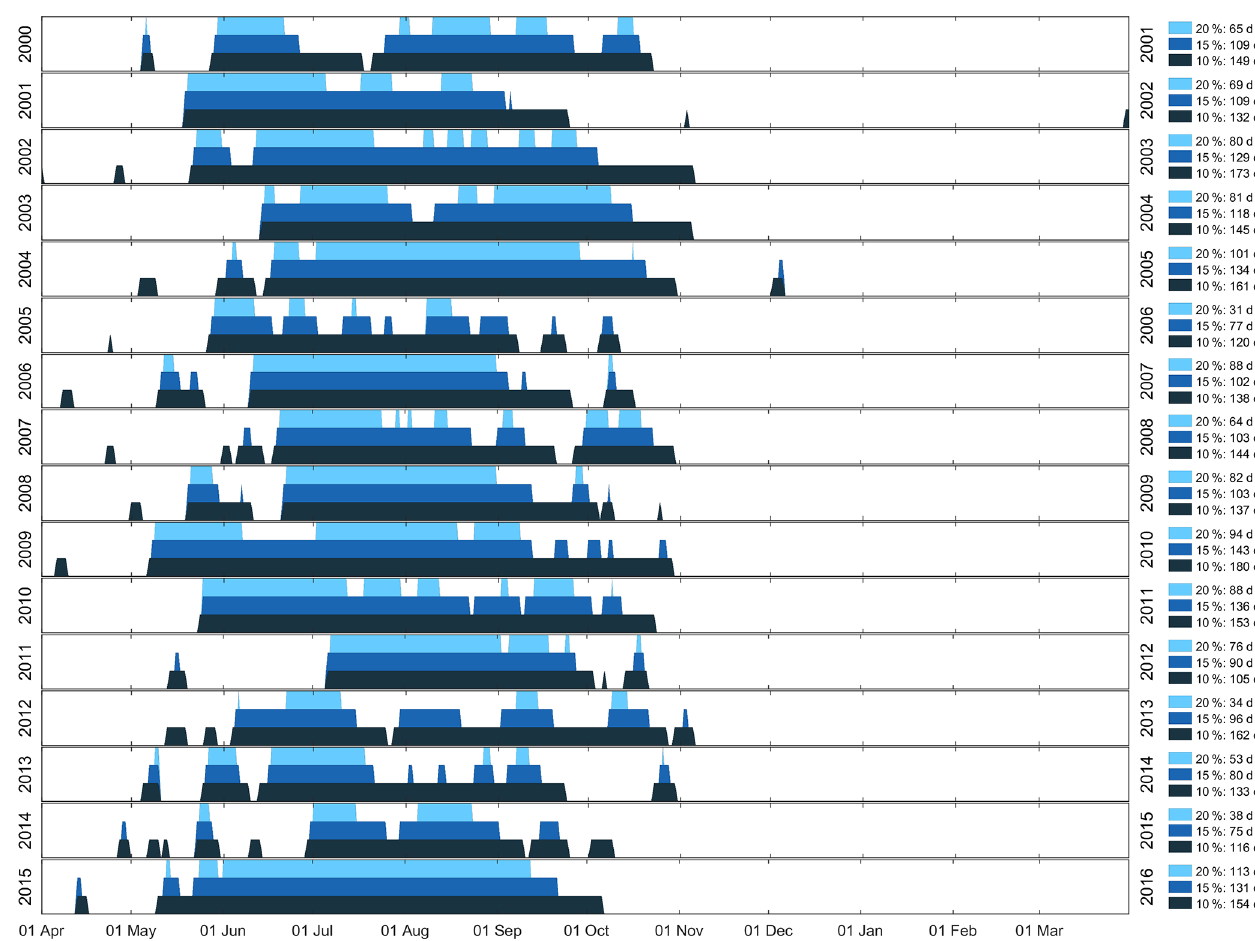
Figure 9. Timeline of occurrence of 10%, 15% and 20% basin snow-covered area (bSCA) for the Clutha Catchment for hydrological years